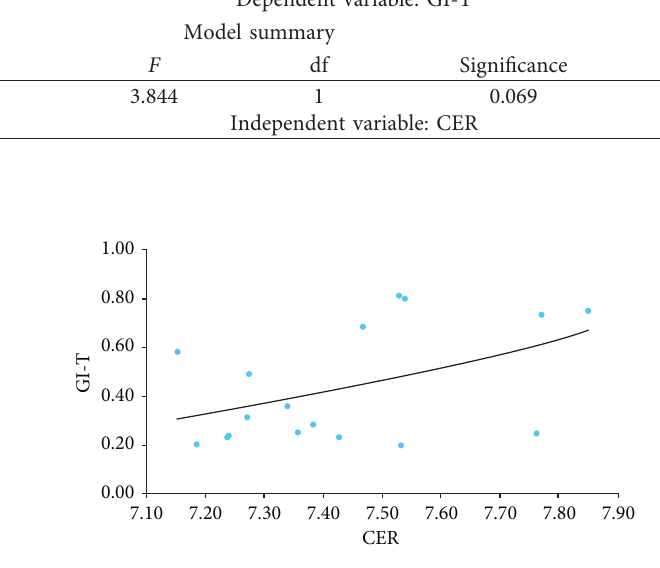
Figure 4: Curve fitting relationship between CER and